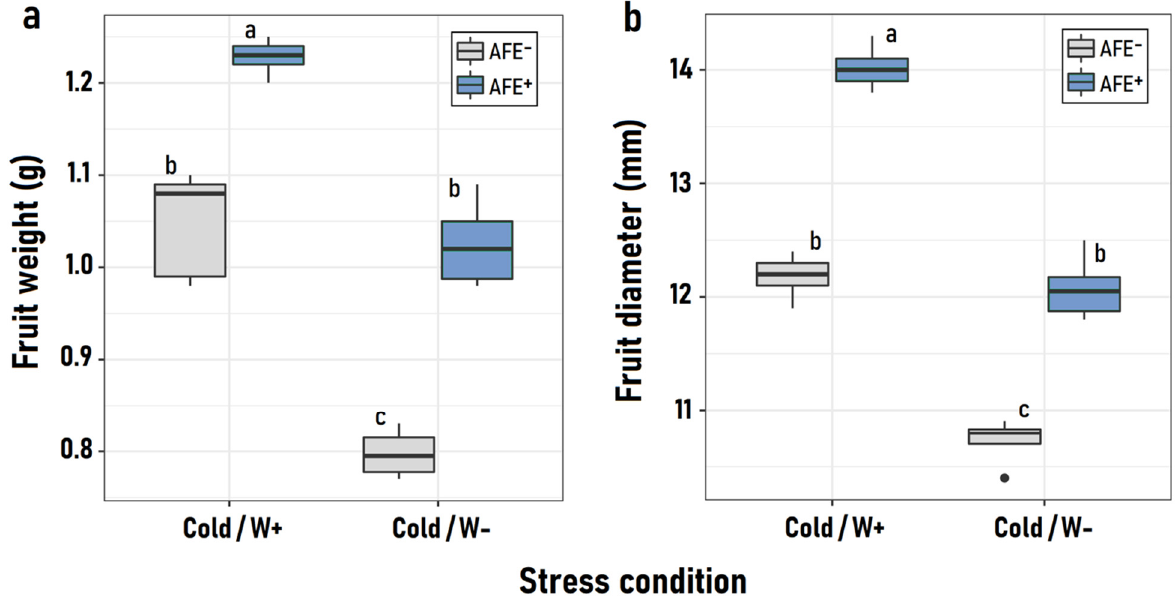
Figure 3. Box plots showing the effects of fungal endophyte inoculation (E+ or E − ) and environmental condition (cold without water deficit (W+) or cold plus water deficit (W − )) on ( a ) fruit size (mm), and ( b ) weight (g) in blueberry plants ( Vaccinum corymbosum , cv Briggita). Different letters represent significant a posteriori differences between means (Tukey’s test, p < 0.05) assessed after significant ANOVA models were obtained. The mid black line represents the data group median, while the box and bars represent the interquartile data distribution. Dark gray dots represent data outliers.